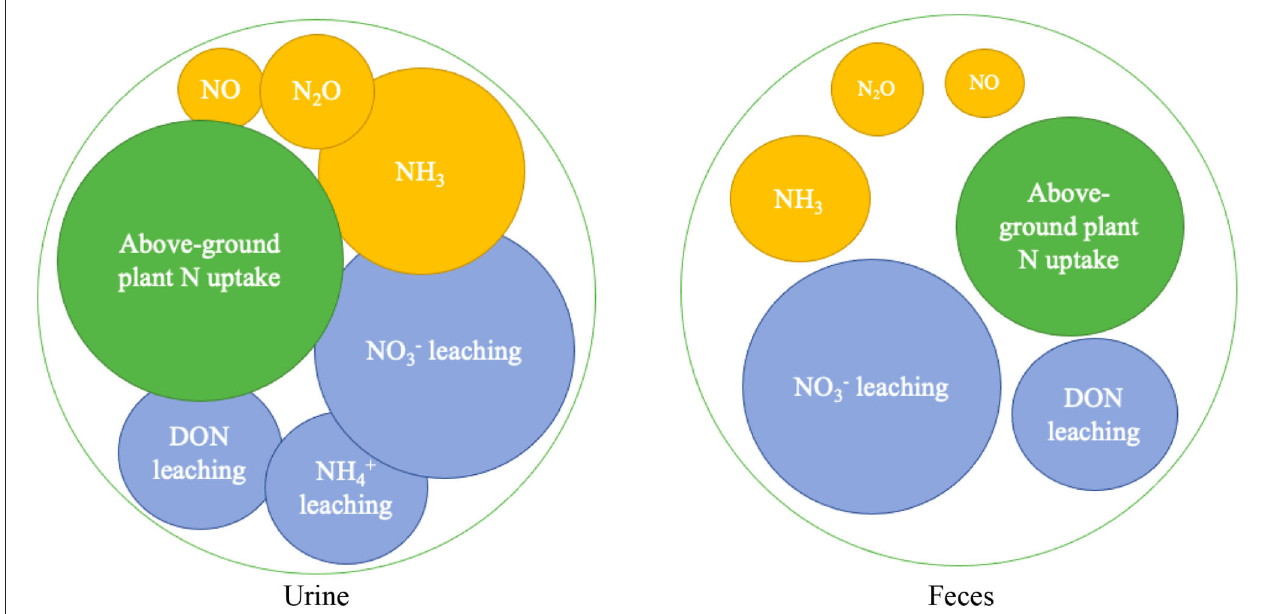
FIGURE 2 | Fate of nitrogen losses from cattle urine and feces patches distinguished into a leaching (blue), gaseous (orange) and plant uptake (green) component. DON stands for dissolved organic nitrogen. The size of the circles can be put into perspective compared to the two large black circles that reference a patch nitrogen load of 1,000g. Figure adapted from Cai and Akiyama (2016) and Wecking